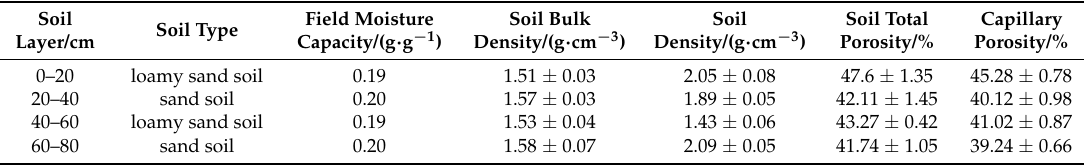
Table 1. Soil properties used in the